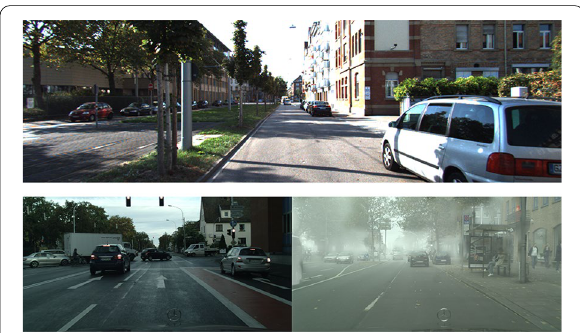
Figure 3 Illustrated images for each dataset (top: KITTI, bottom-left: Cityscapes, bottom-right: Foggy Cityscapes)